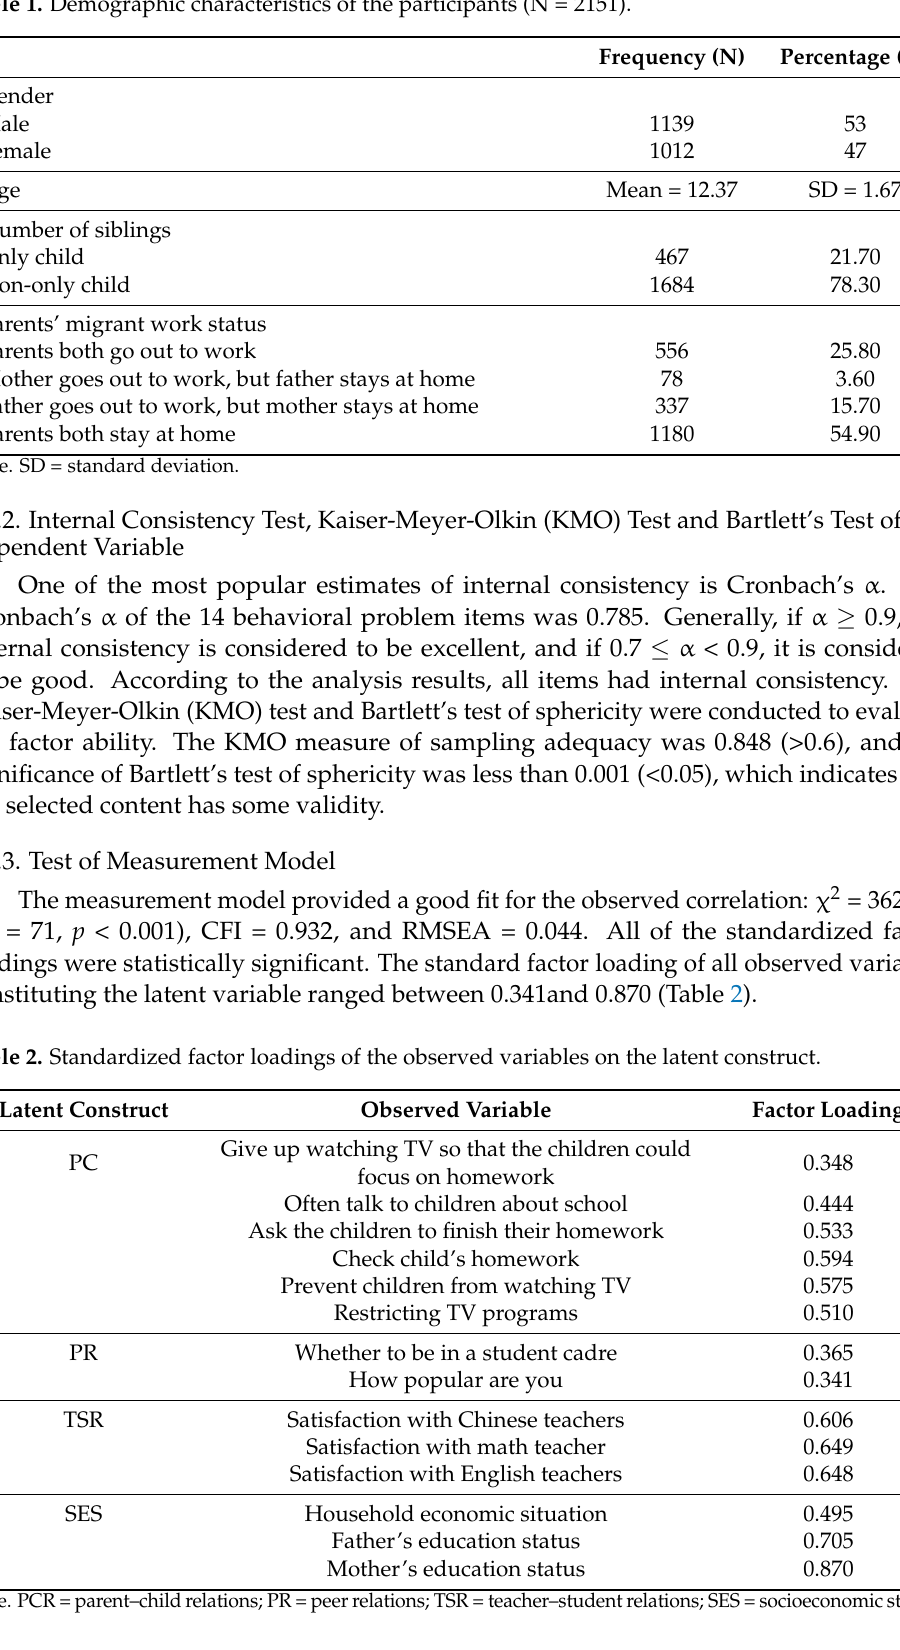
Table 1. Demographic characteristics of the participants (N = 2151).